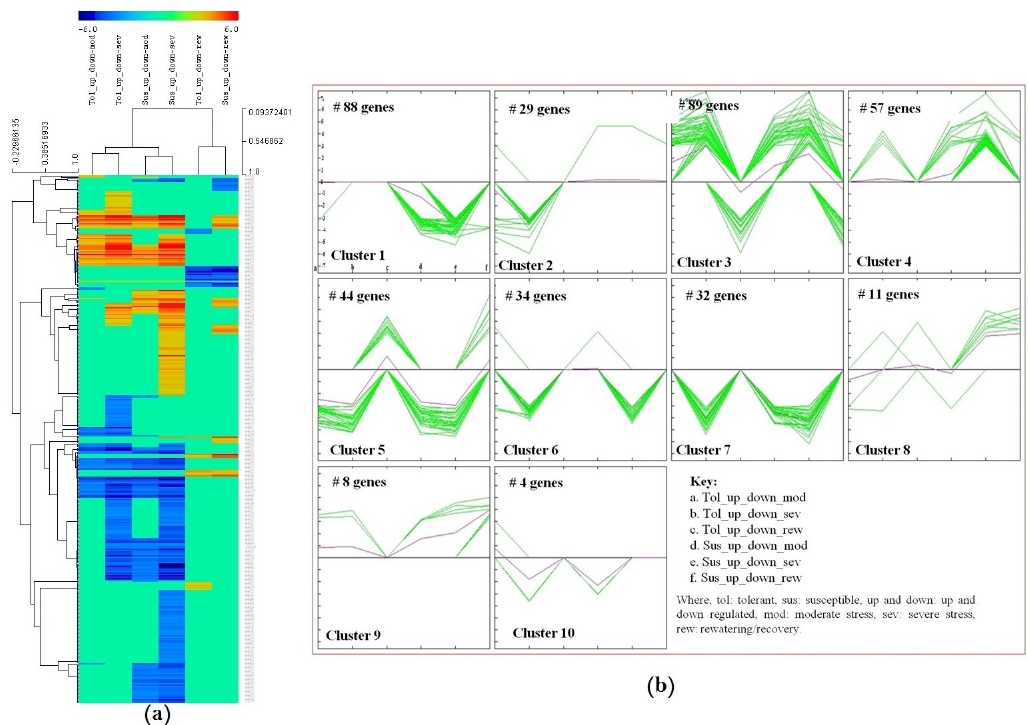
Figure 9. ( a ) Heatmap of differentially expressed transcripts in tolerant and sensitive maize genotypes during drought stress and recovery. The transcripts showing >3-fold change expression were selected for this analysis. ( b ) Gene cluster analysis of differentially expressed transcripts. The number of genes in each cluster are indicated, ‘+’ and ‘-‘ signs indicate up- and downregulation, respectively, in all the 10